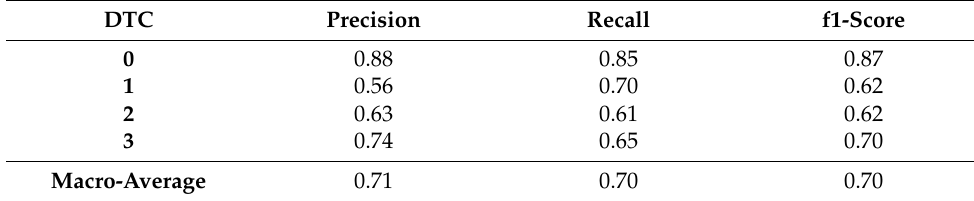
Table 6. Performance of DTC.